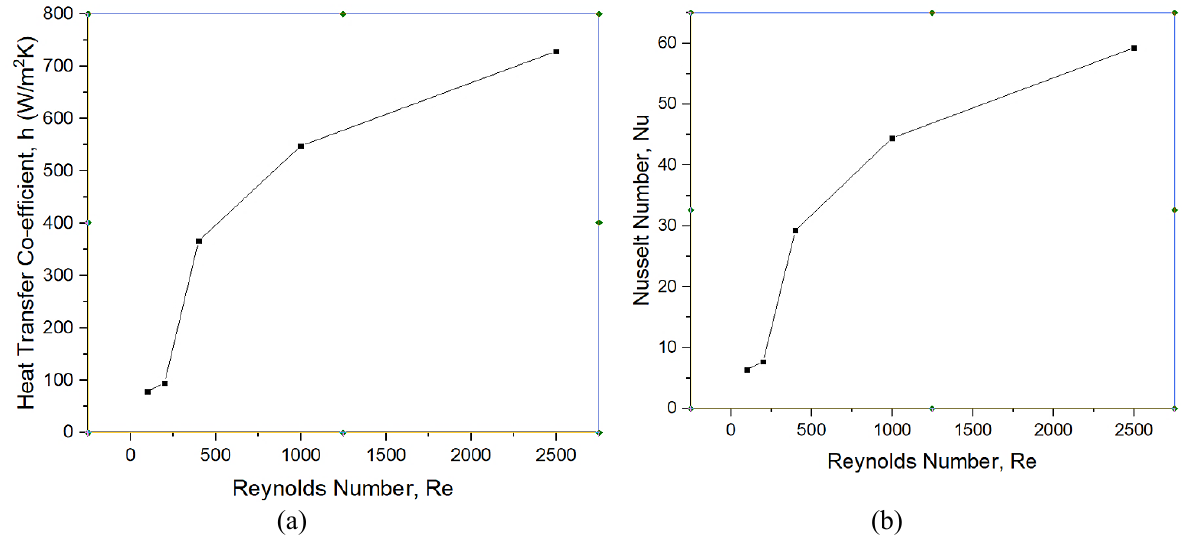
Fig. 8. Effect of (a) Heat transfer Co-efficient and (b) Nusselt Number in Multi-restriction